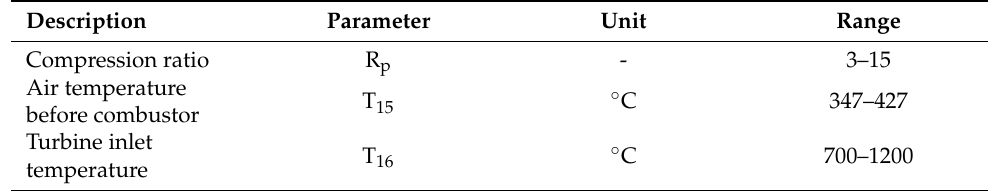
Table 4. Decision variables [38,48].